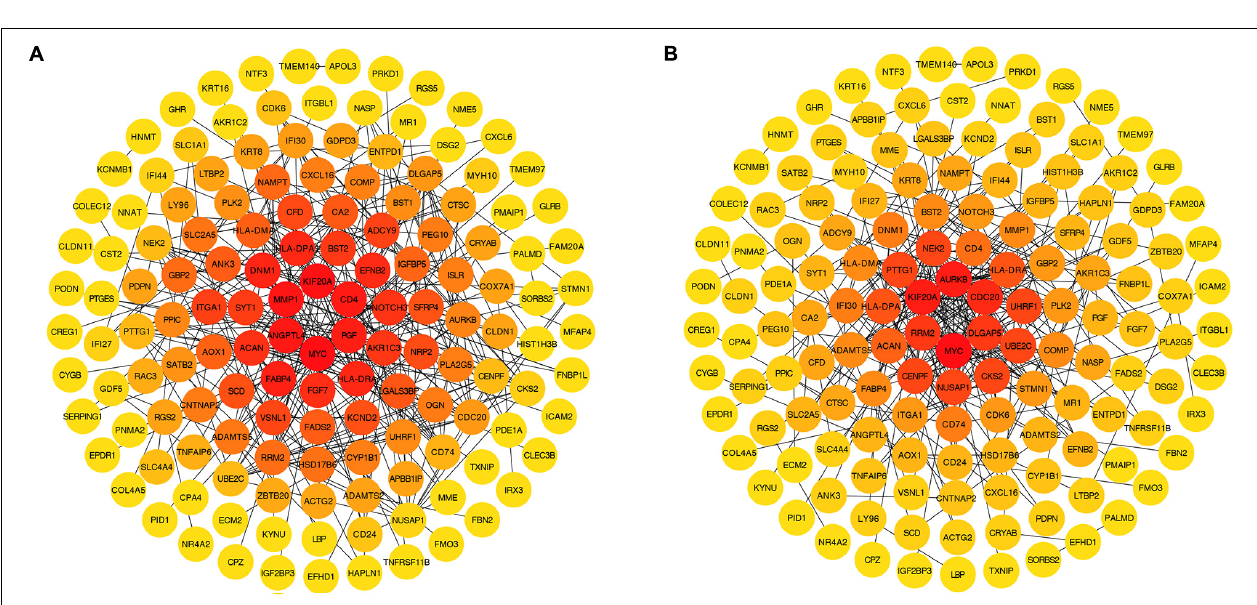
FIGURE 5 | Kyoto Encyclopedia of Genes and Genomes (KEGG) analysis of robust DEGs. Chord plot (A) and circle plot (B) show the relationship between genes and KEGG pathways. (A) Chord plot depicting the relationship between genes and the top five KEGG pathways. (B) Circle plot depicting the distribution of genes in the top 10 KEGG